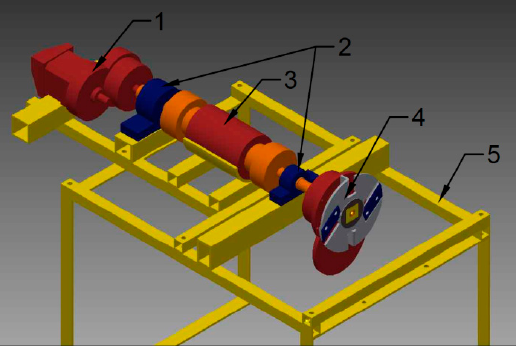
Figure 2. Design of a device for measuring the resistance of cutting stalks: 1—electric motor, 2—bearing, 3—torque gauge, 4—cutting set, 5—frame.